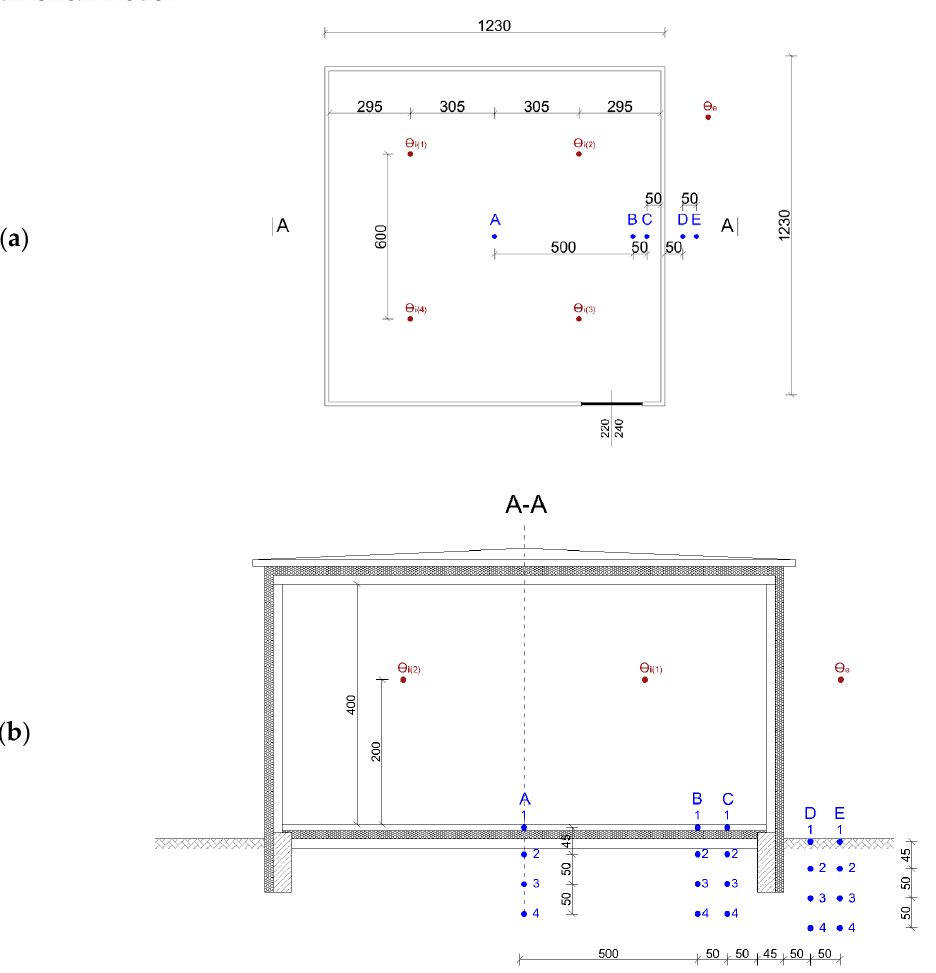
Figure 1. Diagram of the studied facility and arrangement of the measurement points of the floor, soil, and internal and external air temperatures: ( a ) projection; ( b ) cross ‐ section. soil, and internal and external air temperatures: ( a ) projection; ( b )